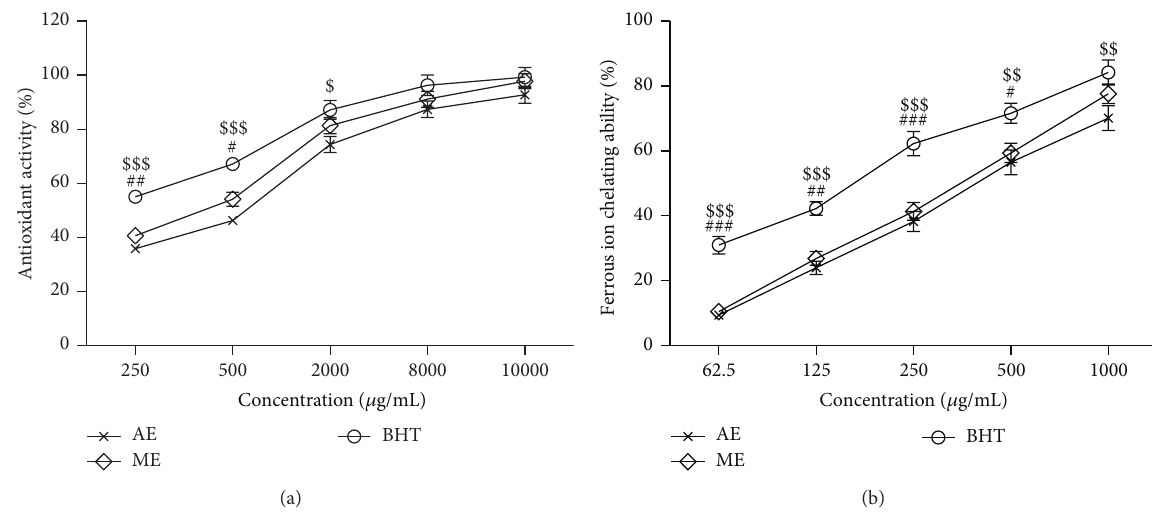
Figure 4: (a) % Antioxidant activity using 𝛽 -carotene bleaching rate. (b) Chelating effect on ferrous ion, of BHT, AE, and ME seed extracts of Abelmoschus esculentus . Data are representative of three independent experiments. Values are mean ± S.E.M. The significance of differences was analysed by two-way ANOVA followed by Bonferroni multiple comparisons test (AE versus ME, ∗ 𝑃 < 0.05 ; ∗∗ 𝑃 < 0.01 ; ME versus BHT, # 𝑃 < 0.05 ; ### 𝑃 < 0.001 ; AE versus BHT, $ 𝑃 < 0.05 ; $$ 𝑃 < 0.01 ; $$$ 𝑃 < 0.001 ). (a) Treatment: F (2, 30) = 29.02, 𝑃 < 0.0001 ; concentration: F (4, 30) = 195.43, 𝑃 < 0.0001 ; interaction (treatment × concentration): F (8, 30 = 1.51, n.s). (b) Treatment: F (2, 30) = 58.46, 𝑃 < 0.0001 ; concentration: F (4, 30) = 207.34, 𝑃 < 0.0001 ; interaction (treatment × concentration): F (8, 30 = 1.18, n.s).